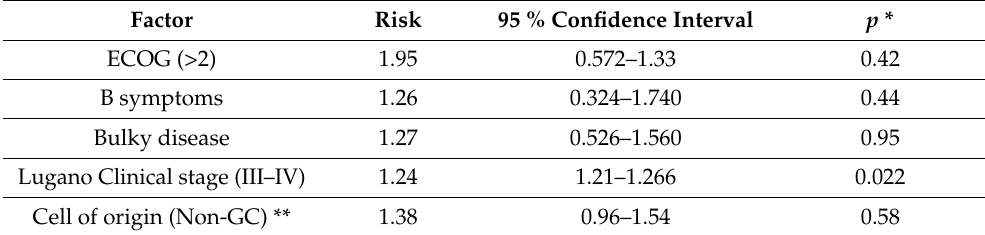
Table 4. Multivariate analysis of factors influencing clinical